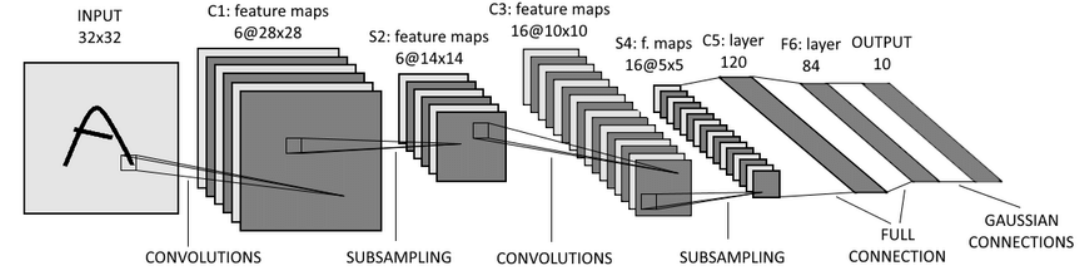
Figure 4. Architecture of the convolutional neural network (LeNet)—image source [48].